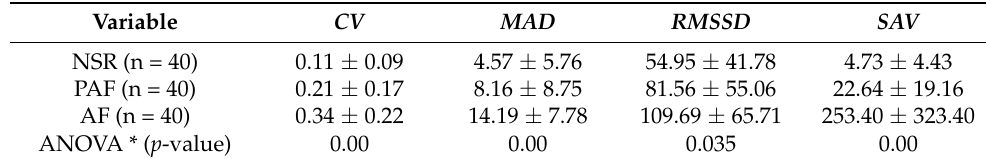
Table 1. Mean ± standard deviation of variables and ANOVA test.